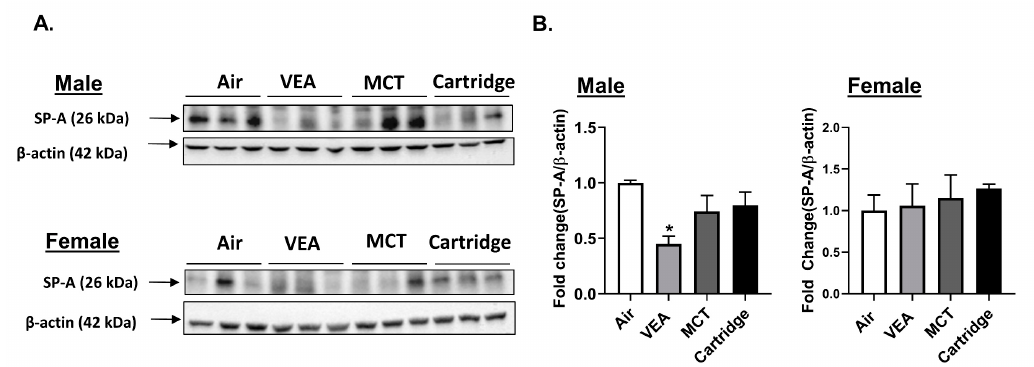
Figure7. Surfactant-associatedproteinA(SP-A)wasreducedinVEA-exposedmouselunghomogenates. ( A ) Surfactant-associated protein A (SP-A) protein abundance in mouse lung homogenates from C57Bl / 6 background male and female mice was determined by immunoblot analysis. ( B ) The quantified results are expressed as means ± SEM. Significance was determined by one-way ANOVA with Bonferroni’s correction for multiple comparisons. * p < 0.05 vs. air. p > 0.05 were considered not significant and were not denoted with asterisks ( n = 3 per group for either sex). The same blot was probed for ACE2, TMPRSS2, Furin, and SP-A. Thus, the same beta-actin band (for males) appears in both Figure 7 (SP-A) and Figure 10 (SARS-CoV-2 related